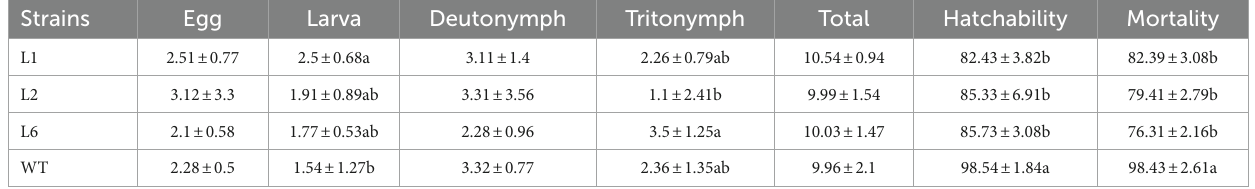
TABLE 1 The developmental durations (days) for T. putrescentia e reared on Polec2 overexpressing strains at 25 ° C and 85% RH. Strains Egg Larva Deutonymph Tritonymph